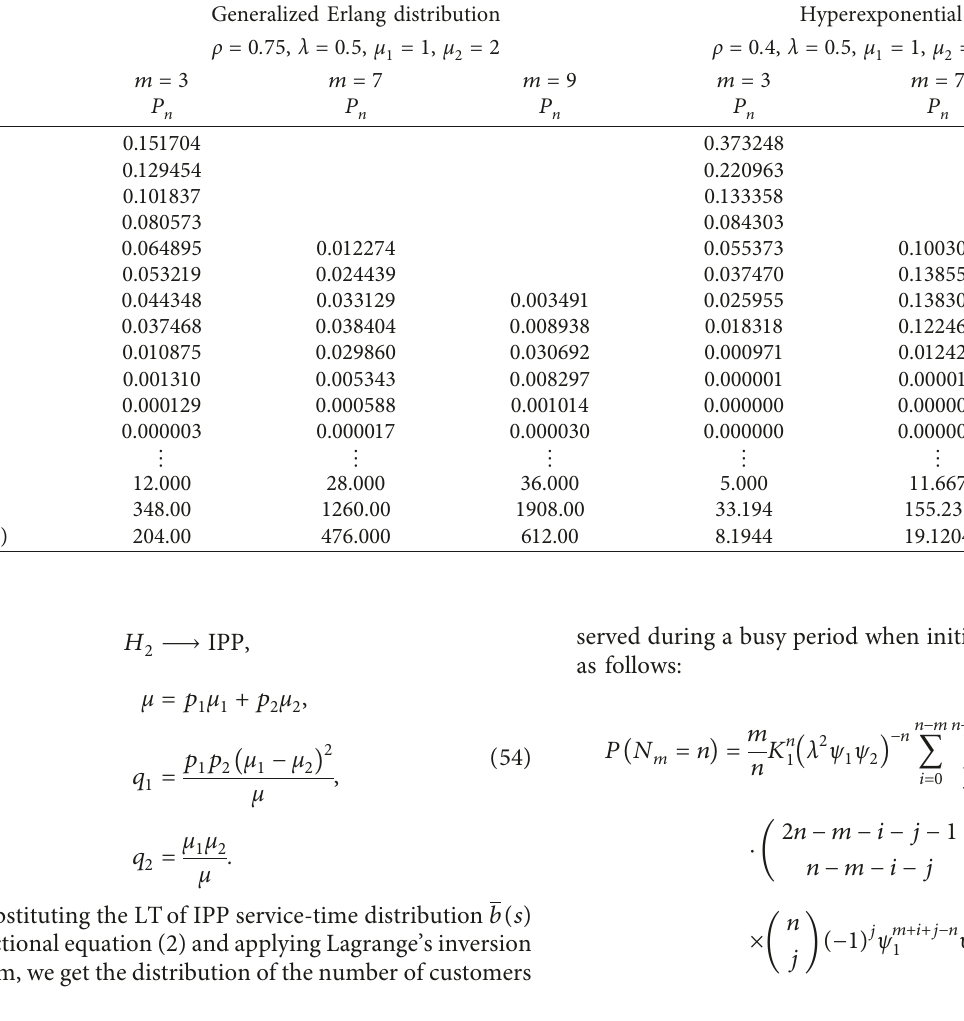
Table 2: Distribution of the number of customers served during a busy period. n